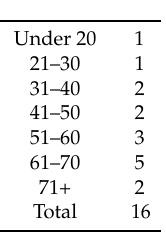
Table 2. Age of workshop participants.